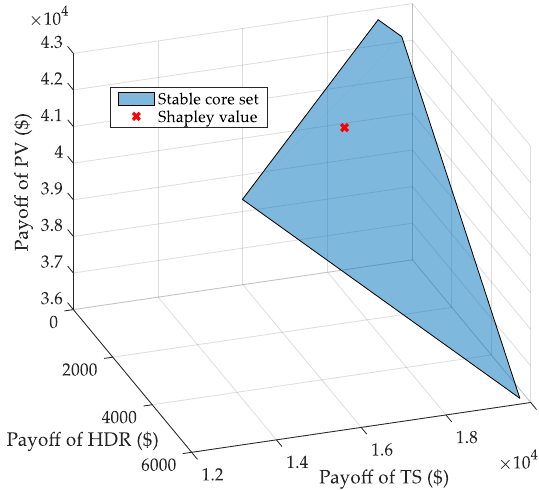
Figure 9. Stability of the Shapley value.